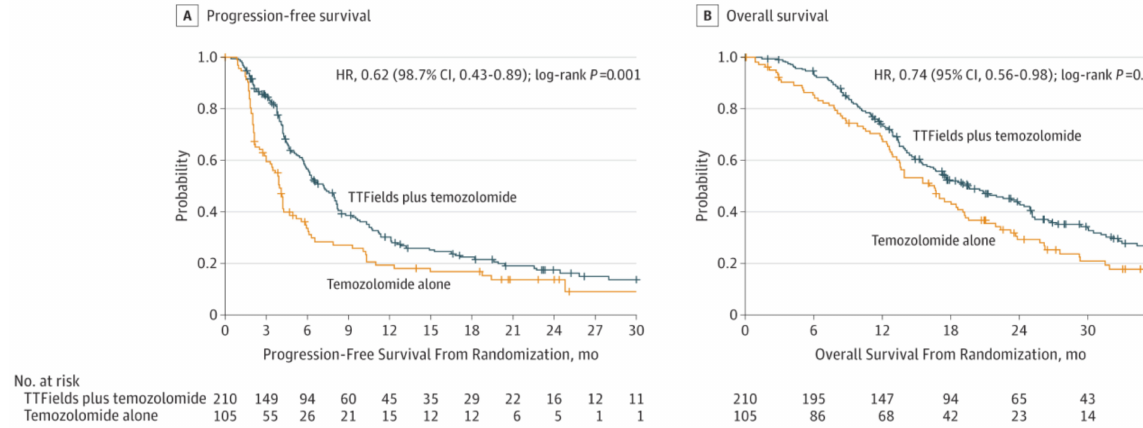
Figure 5. ( A ) Progression-free survival of glioblastoma patients with tumor-treating fields plus temozolomide compared to temozolomide alone. ( B ) Overall survival of glioblastoma patients with tumor-treating fields plus temozolomide compared to temozolomide alone [36]. Used with